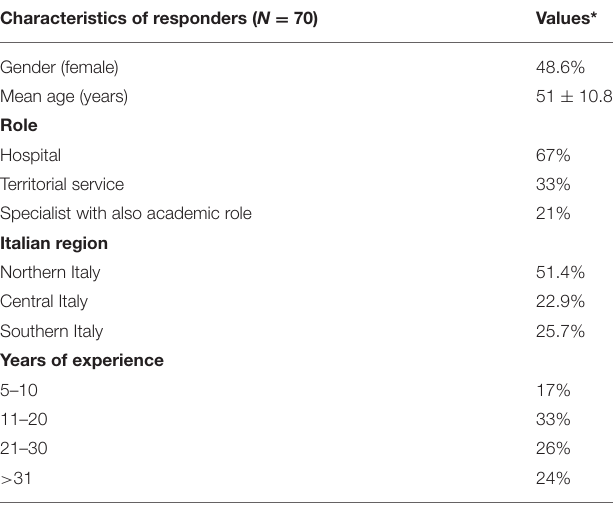
TABLE 1 | Characteristics of responders in the Delphi